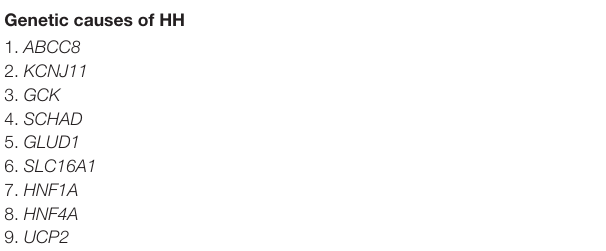
TABLe 1 | An outline of different causes of HH. Genetic causes of